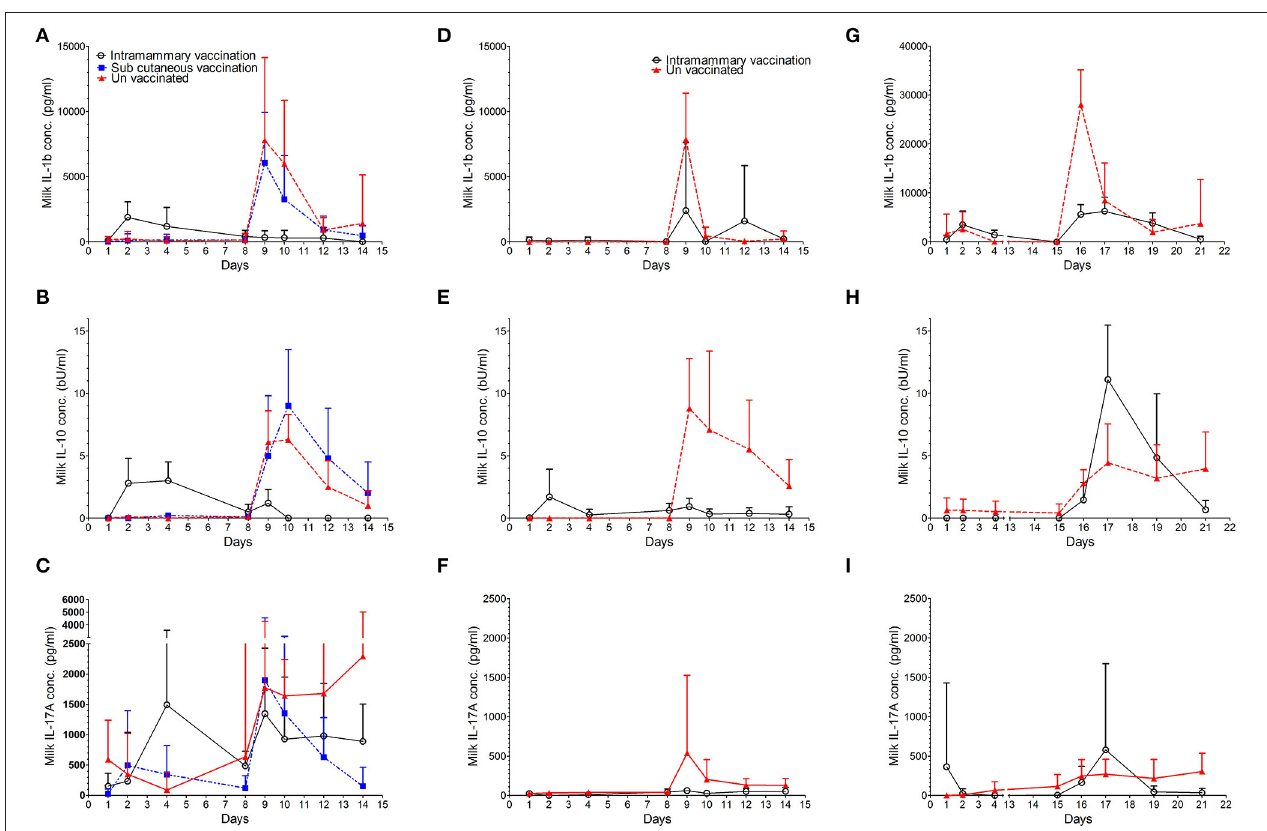
FIGURE 4 | Concentration of cytokines IL-1 β , IL-10, and IL-17A in milk. The average concentration with standard deviation is shown for IL-1 β in study 1 (A) , study 2 (D) , and study 3 (G) . The average concentration with standard deviation is shown for IL-10 in study 1 (B) , study 2 (E) , and study 3 (H) . The average concentration with standard deviation is shown for IL-17A in study 1 (C) , study 2 (F) , and study 3 (I) .